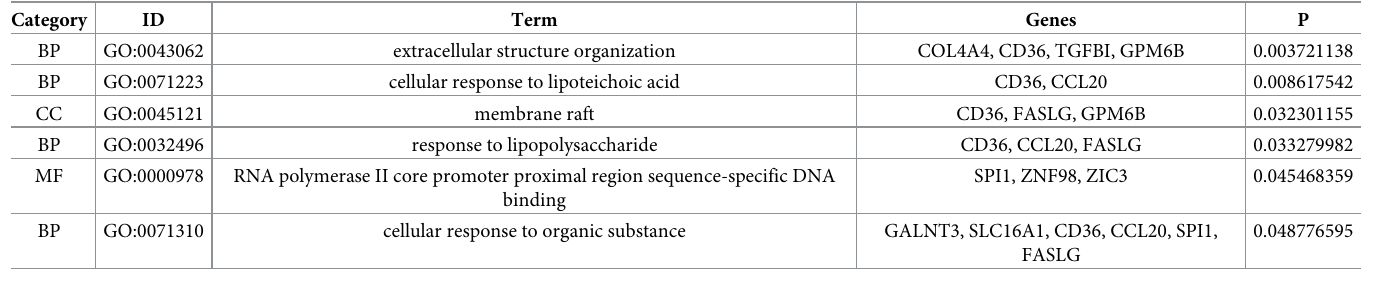
Table 7. GO terms of DEmRNA in kidney renal clear cell carcinoma.